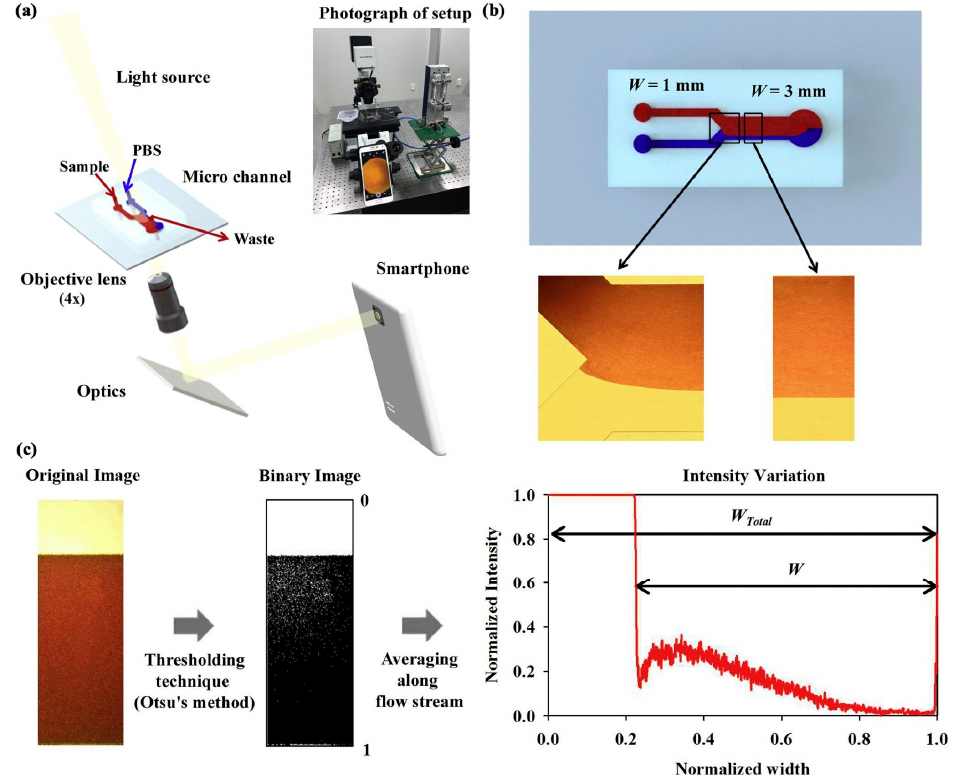
Figure 9. A smartphone microscope attachment ( a ) images a microfluidic device ( b ), testing viscosity of different samples using the image processing method ( c ). Reproduced from [94] with permission. © 2018 Elsevier.